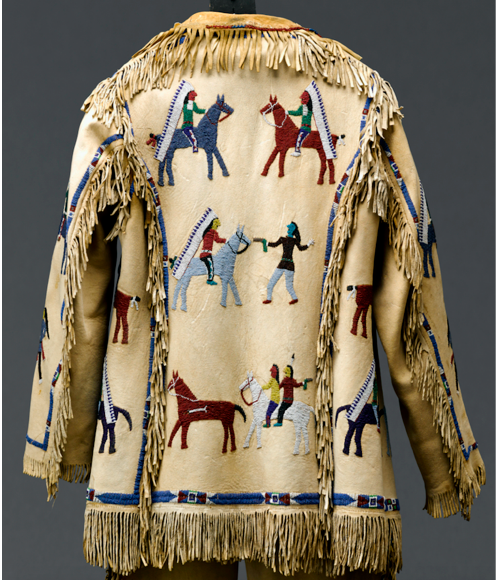
Figure 8. Regalia of It ȟ ú ŋ kasa ŋ Glešká. Detail of back (Figure 2b). Musée franco-américaine du château de Blérancourt. Photograph taken by Adrien Didierjean and used by permission of RMN-Grand Palais/Art Resource, NY.